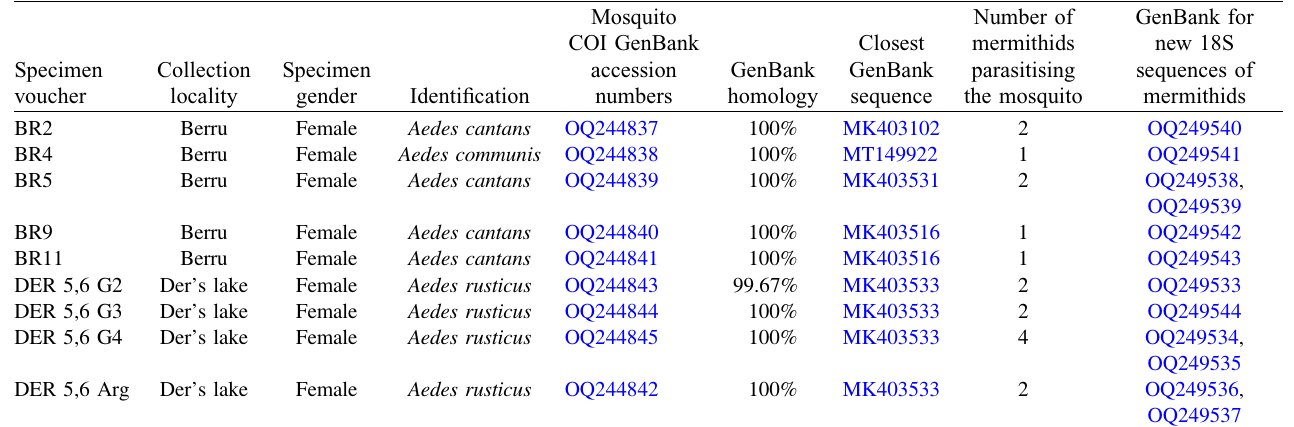
Table 1. Mosquitoes, their mermithids and